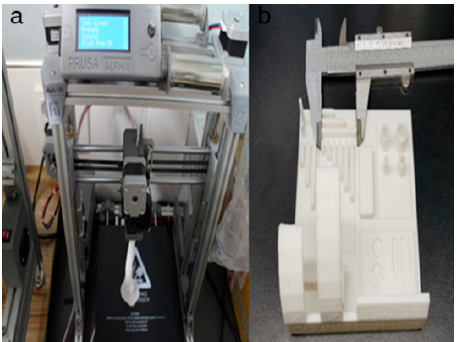
Figure 3. Printer for the in-house fabrication. In this study, the desk-top fused deposition modeling 3-D printer was employed for the in-house fabrication from polylactic acid filaments ( a ). Before the thesis research work, accuracy checking process for this 3-D printer was performed using 3-D accuracy-test tool ( b